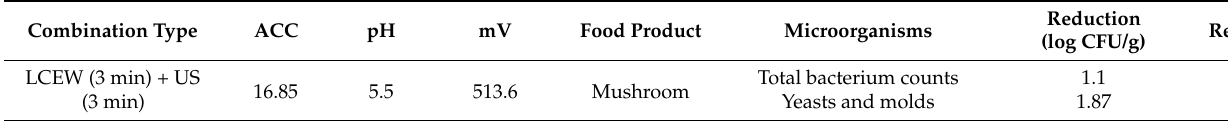
Table 4. Combination of EW with other treatment procedures to decontaminate